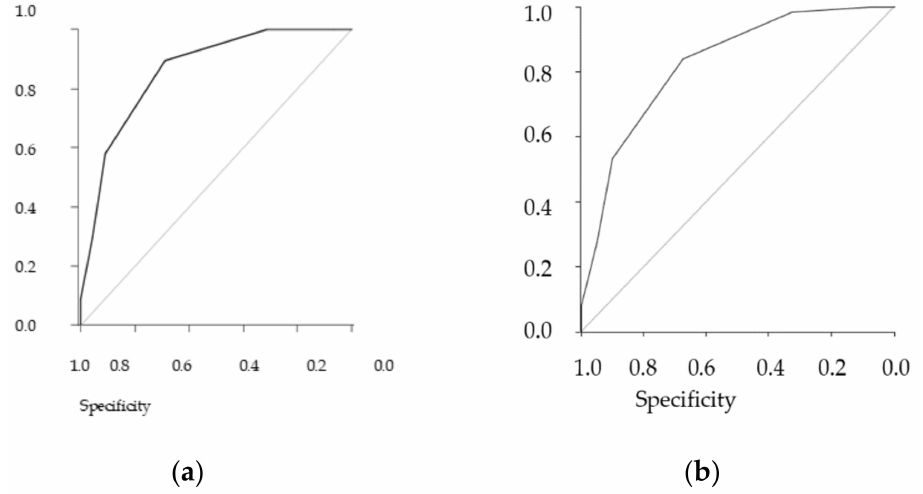
Figure 1. Receiver operating curve (ROC). ( a ) ZFS predictive ROC curve for CGA, AUC = 0.86, ( b ) ZFS predictive ROC curve for Fried ≥ 3, AUC = 0.83.